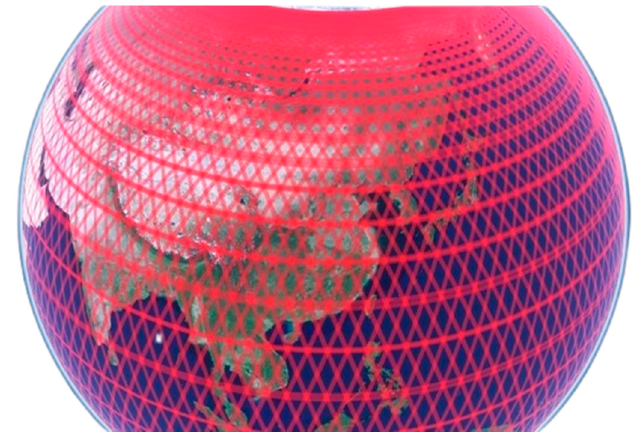
Figure 4. Illustration of fishnet coverage of altimetry satellite orbits.